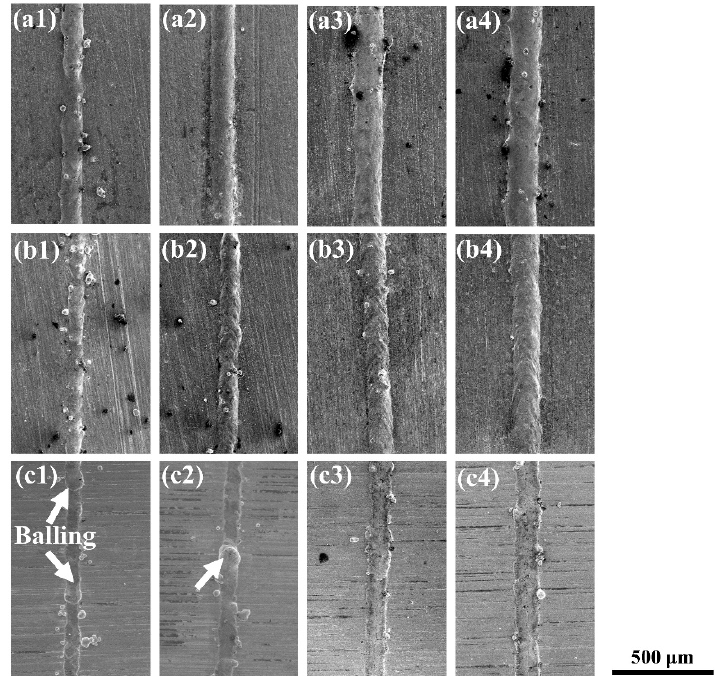
Figure 3. Single tracks formed on different substrates: ( a1 – a4 ) single tracks formed on the 316L substrate with laser power from 95 to 185 W; ( b1 – b4 ) single tracks formed on the Ni200 substrates with laser power from 95 to 185 W; ( c1 – c4 ) single tracks formed on the YG15 substrate with laser power from 95 to 185 W.